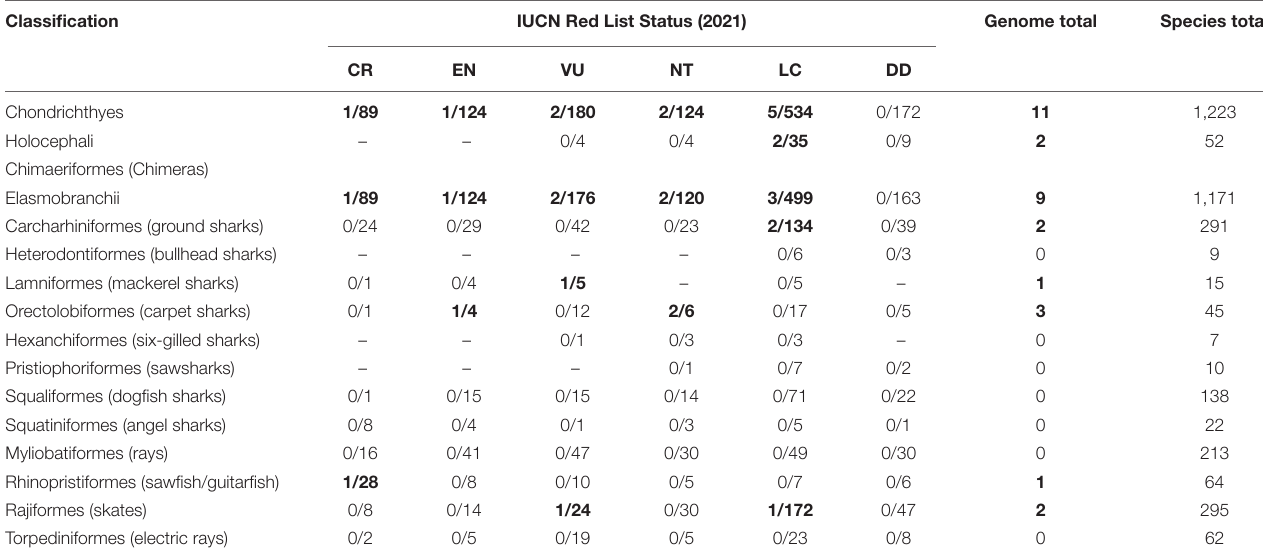
TABLE 2 | IUCN Red List conservation status of species within the Chondrichthyes class, divided into subclasses and orders.